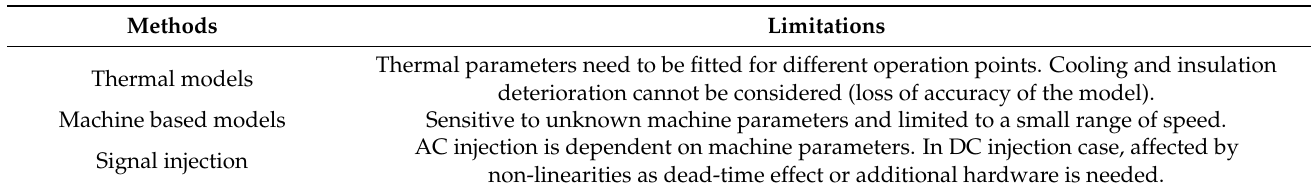
Table 5. Limitation of the different methods previously